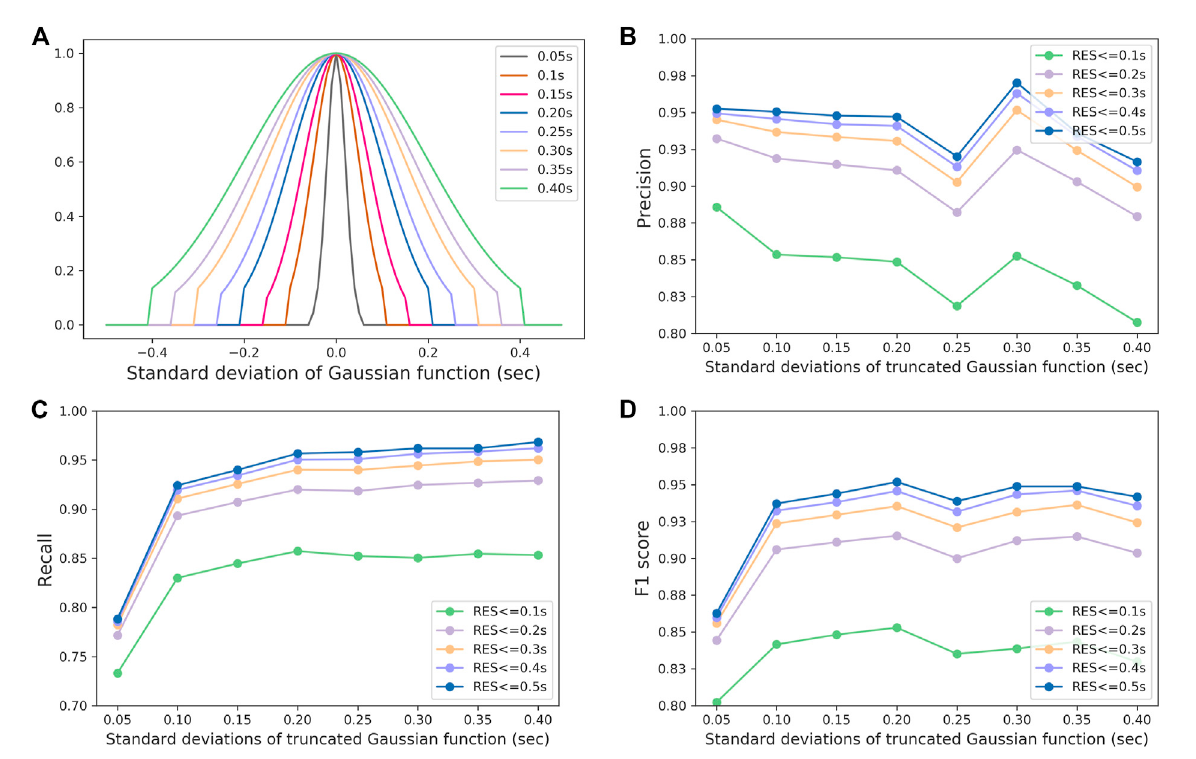
FIGURE 6 Labeling functions with different truncated Gaussian distribution widths (standard deviations) and their effects on the performance of the training model. Illustration of different truncated Gaussian distribution window lengths (A) . Effect of truncated Gaussian window width on precision (B) . Effect of truncated Gaussian window width on recall (C) . Effect of truncated Gaussian window width on F1 score (D) . RES in the fi gure indicates the absolute value of the residuals of predicted and manual